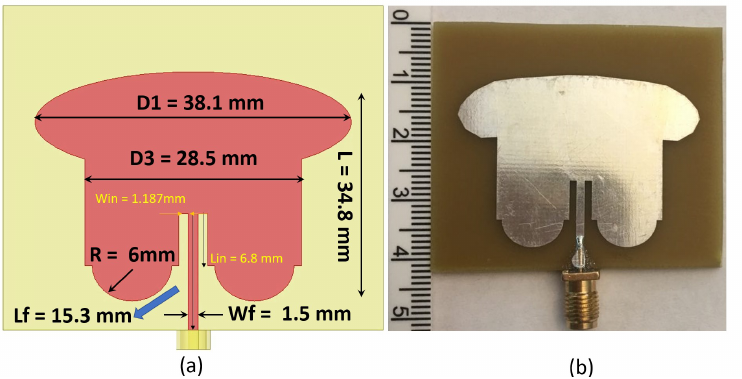
Figure 5. ( a ) Butterfly-shaped patch antenna, ( b ) Photograph of the fabricated